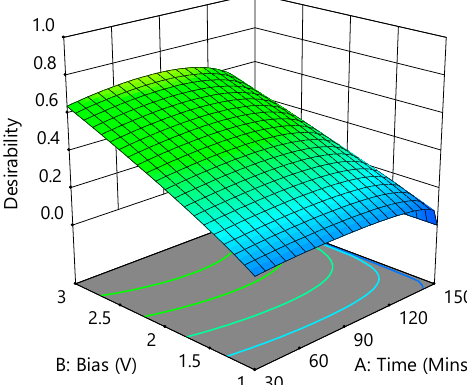
Figure 7. Desirability-fitted 3D surface at an electrode distance of 1 cm. Among 58 starting points, the best CBZ and phosphate removal rate (56.94% and 95.95%, respectively) was found at reaction time—80 min, bias potential—3 V, and electrode distance—1 cm with 0.693 of desirability.